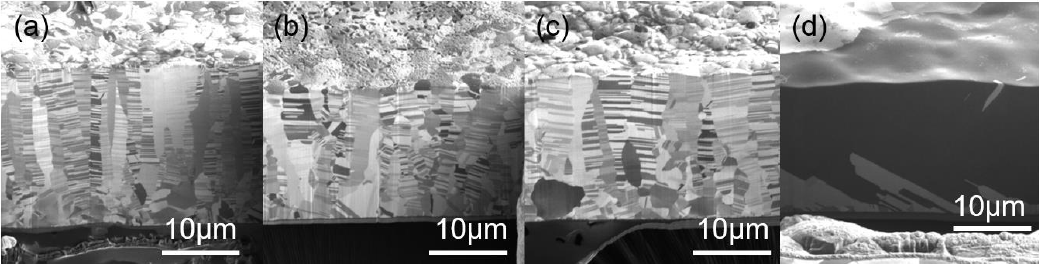
Figure 8 . Cross-sectional ion images of the type-B nt-Cu after annealing at ( a ) 200 °C, ( b ) 300 °C, and ( c ) 400 °C for 1 hour, and ( d ) 400 °C for 3 h.